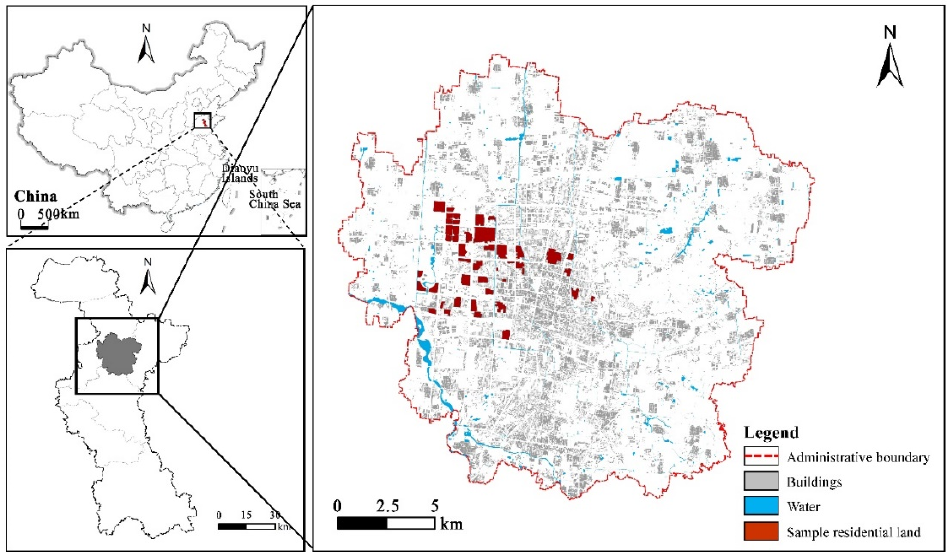
Figure 1. The study area and distribution of residential land samples.